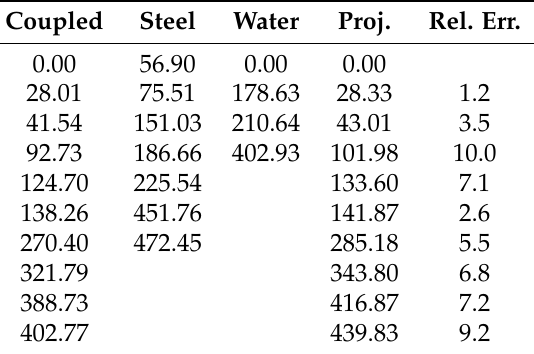
Table 2. Steel-water-structure.